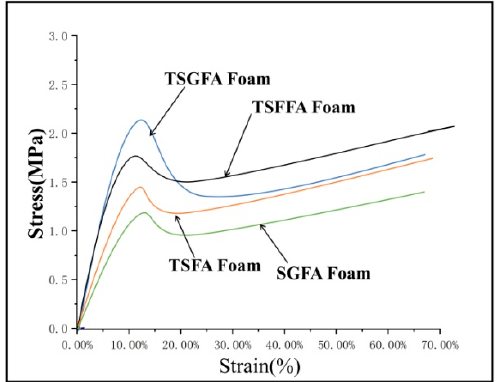
Figure 4. Stress–strain curves of the various foams.